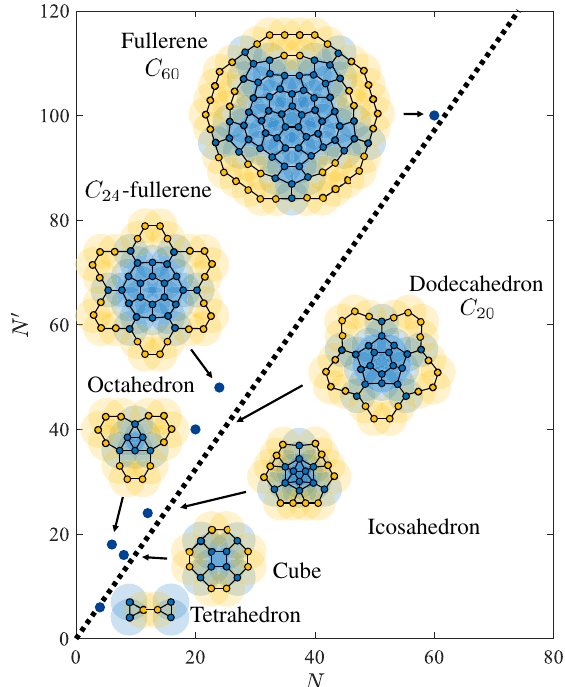
FIG. 5. The atom-number scaling of N (cid:6) , of a quantum-wire graph G (cid:6) , versus N , of a target graph G